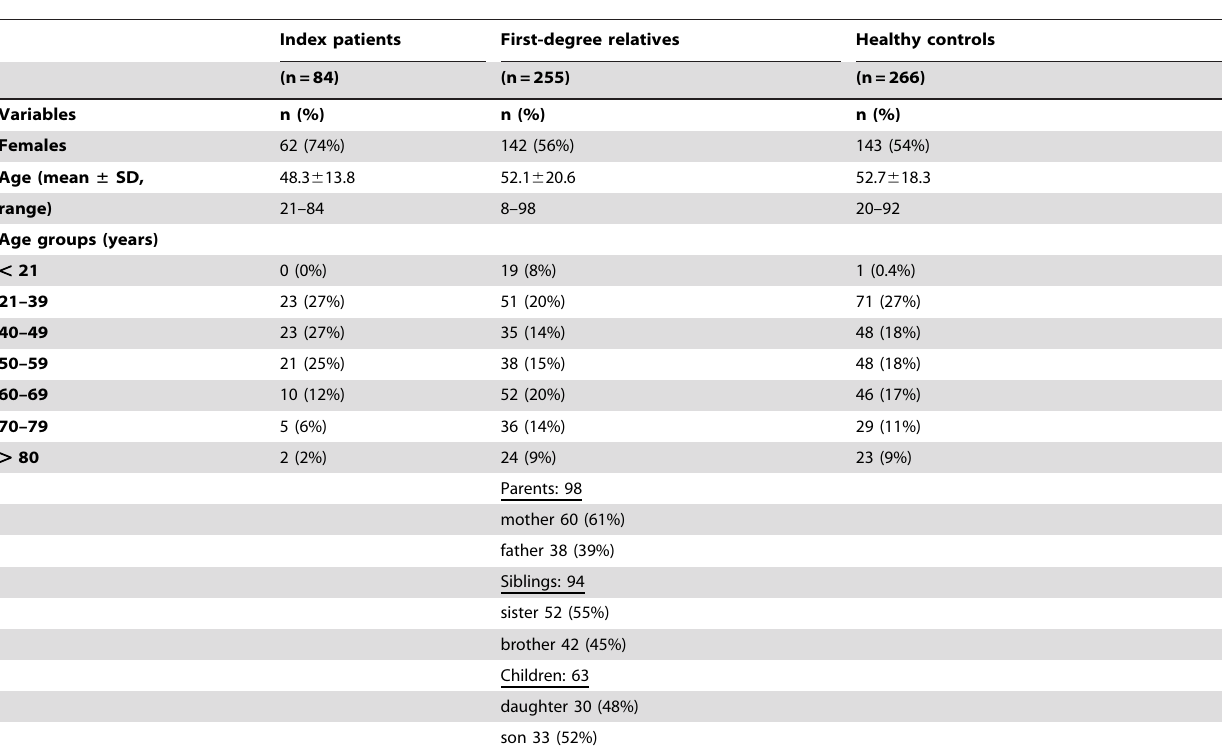
Table 1. Characteristics of index patients, their first-degree relatives, and healthy controls.